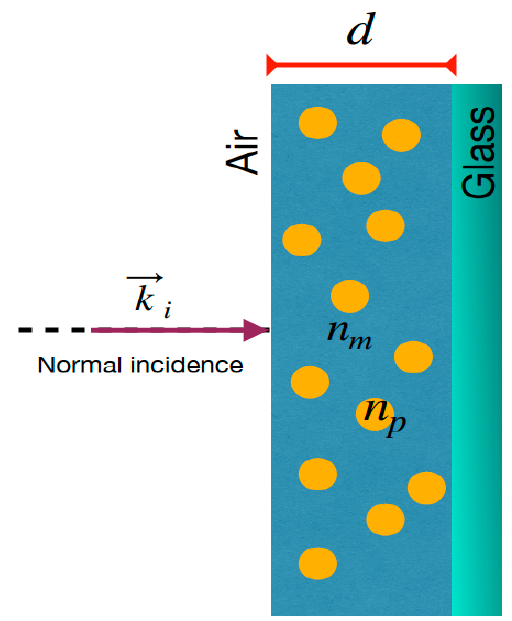
Figure 1. Schematic representation of MoO 3 thin film doped by metallic nanoparticles on a glass substrate showing the normal incidence of the light. k i is the incident wave vector, n m and n p are the refractive index of the matrix medium and the refractive index of the nanoparticles, respectively. 𝑑 is the thickness of the doped thin film.